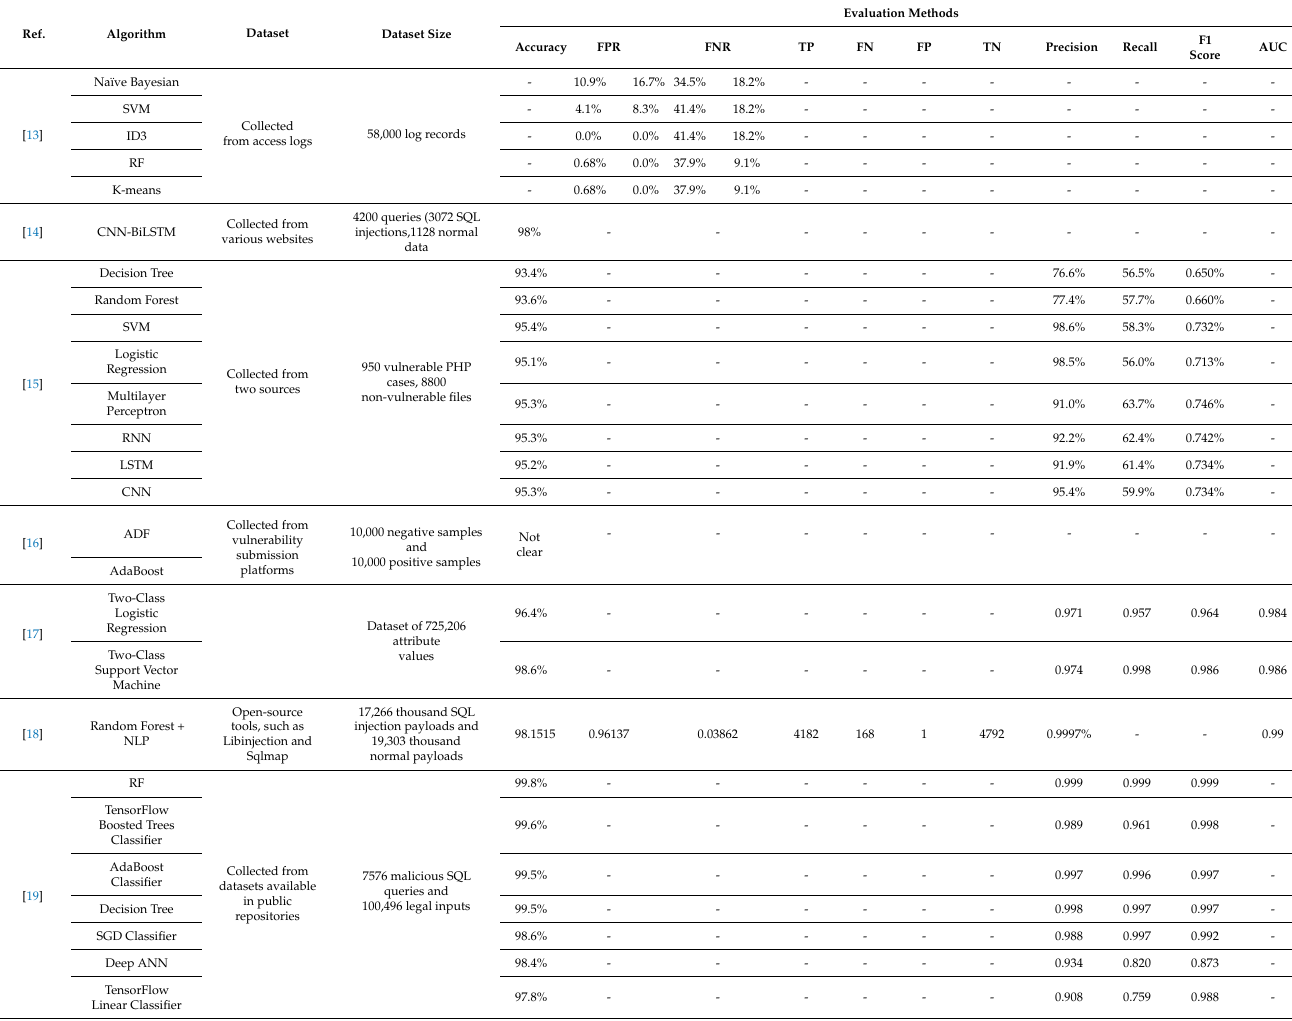
Table 1. Summary of the Machine learning algorithms, Datasets, and Evaluation